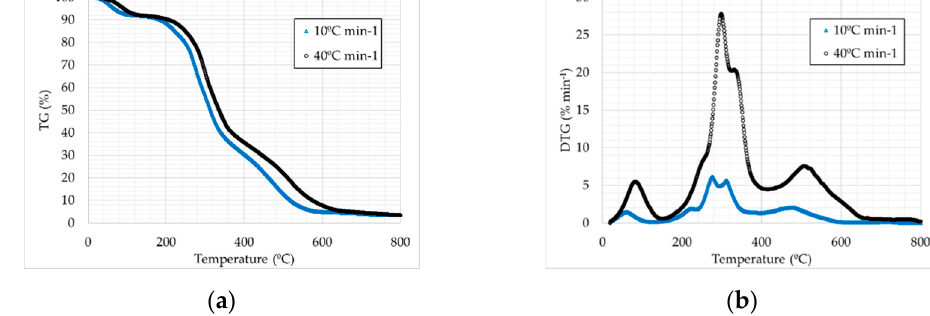
DTG curves (Figures 6b and 7b) at two heating rates were qualitatively similar, con- sisting of one small shoulder peak, one pronounced double peak, and one long tailing. In an oxidative atmosphere, an additional peak was observed.